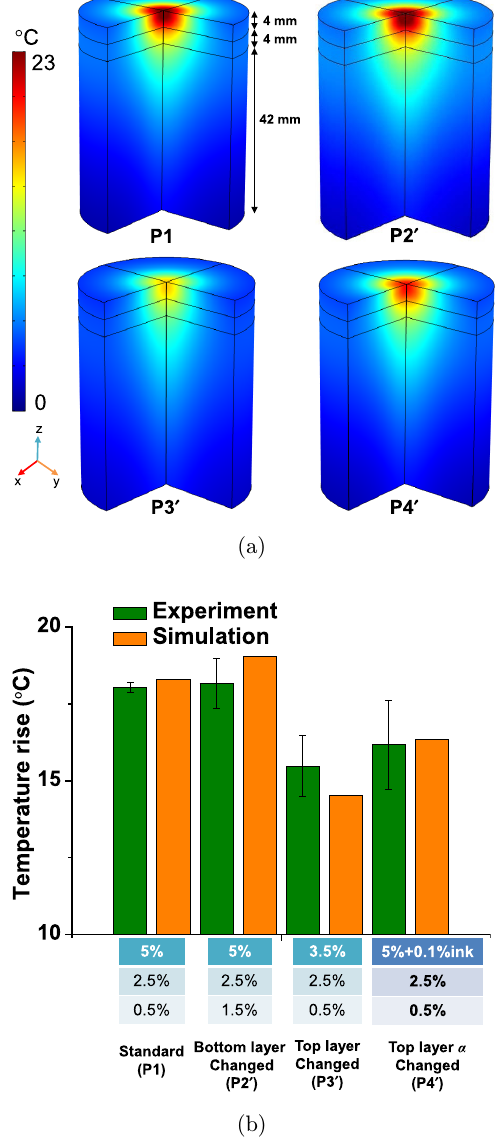
three-quarter phantom with di®erent concentration of agar with 0.5% ink after 2 h and (b) Comparison of temperature variations from experiment and simulation occurring 4 mm below the surface of phantoms with di®erent compositions of agar gel layers with 0.5% ink after 2 h.